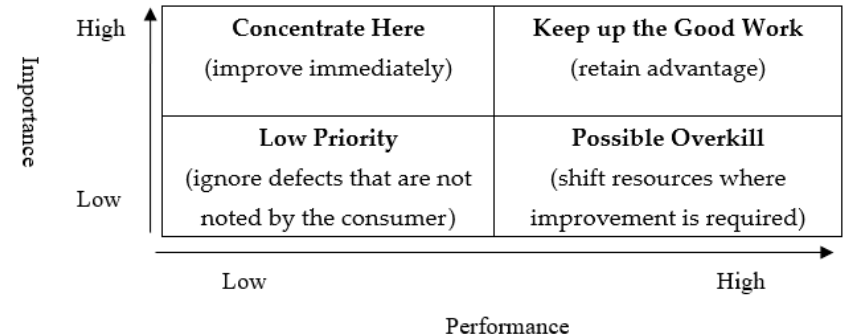
Figure 1. Revised importance–performance analysis (RIPA) Perceptual Map.